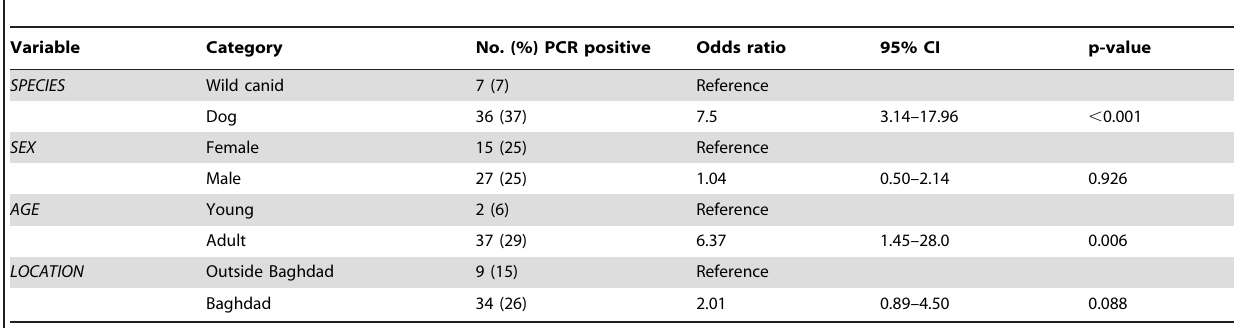
Table 5. Univariate analysis* of factors associated with Bartonella PCR detection in Iraqi canids.